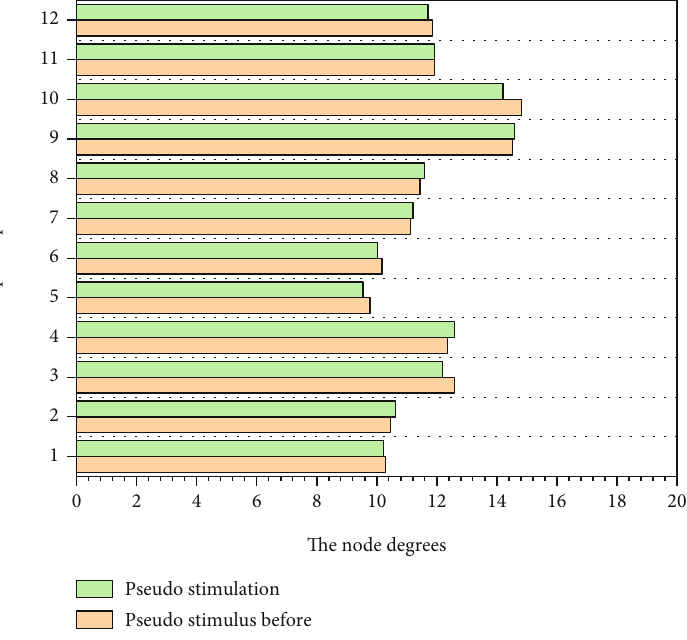
Figure 3: Network node degree before and after